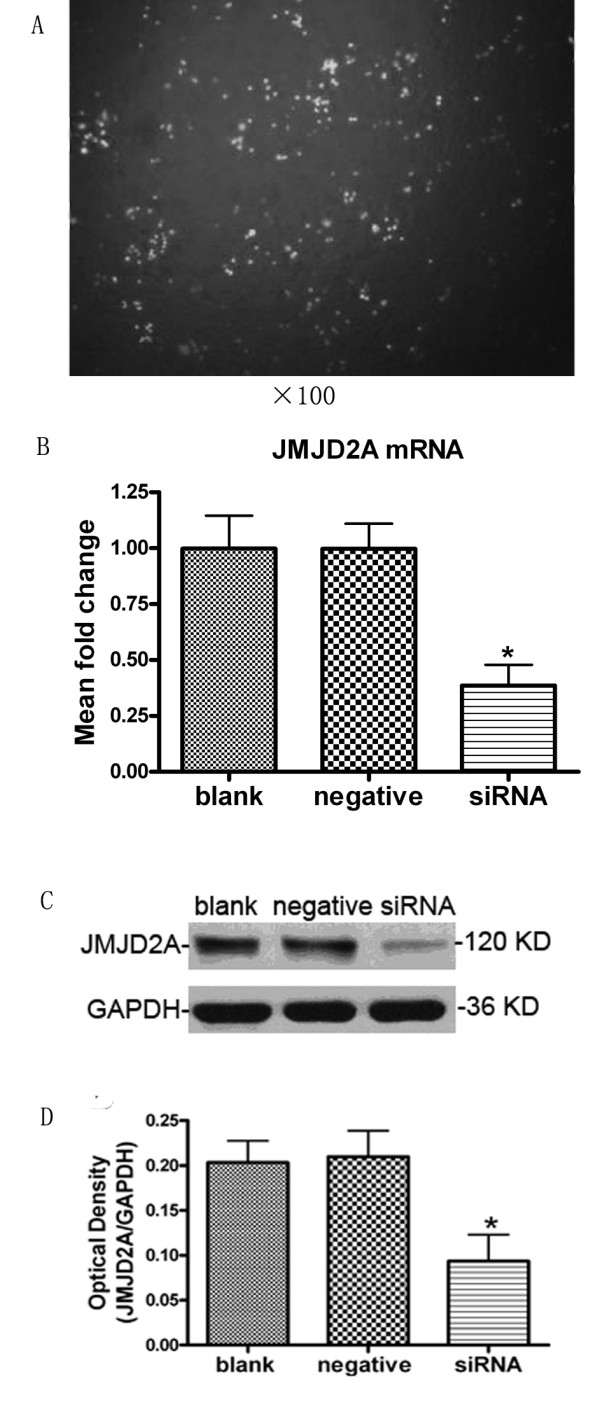
Transfection was successful and levels of JMJD2A mRNA and protein were both down-regulated. A. The green fluorescence cells transfected with FAM-siRNA under fluorescence microscope (Note: ×100). B. Column diagram analysis for mRNA levels of JMJD2A. JMJD2A-specific siRNA resulted in the reduction of JMJD2A mRNA levels in MDA-MB-231 cells. C. Western blot analysis for JMJD2A protein. D. Column diagram analysis for optical density by Western blotting. JMJD2A protein levels were down-regulated in siRNA group. (*P < 0.05, compared with blank control group and negative control group respectively)